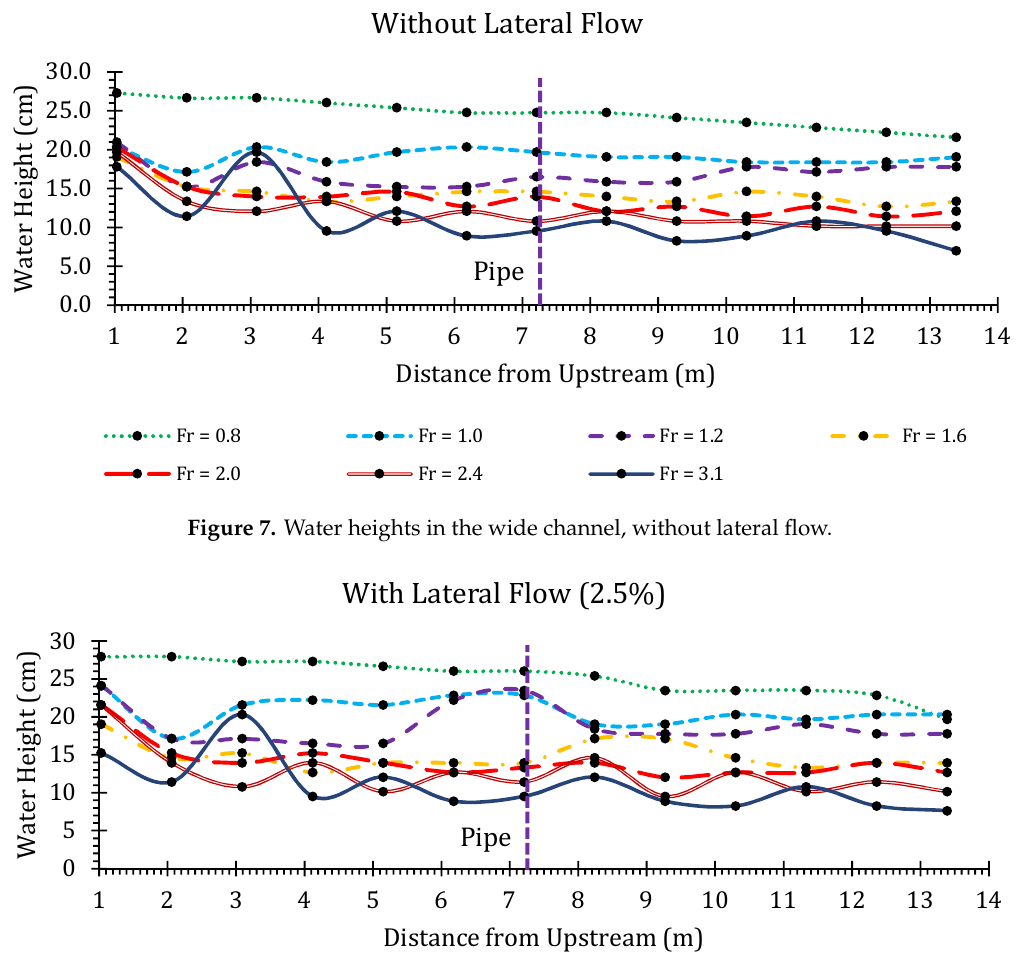
Figure 7. Water heights in the wide channel, without lateral flow.